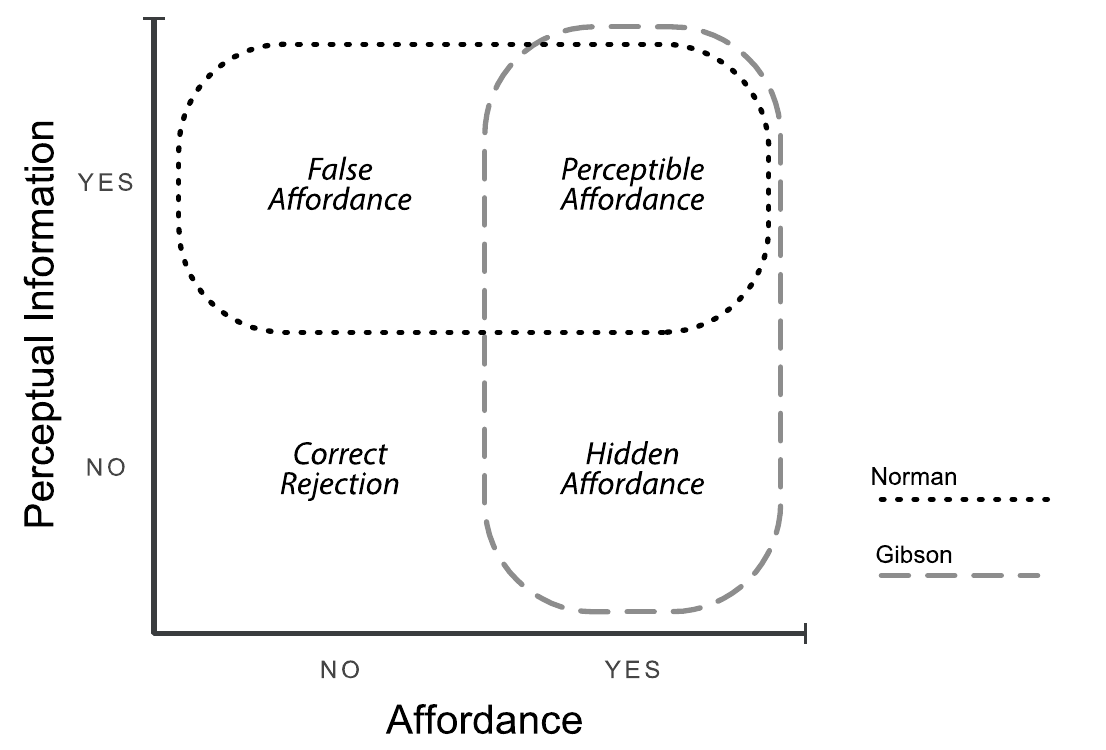
Figure 5. Gibson’s and Norman’s affordance perspectives, adapted from Gaver’s [23] affordance matrix [42].